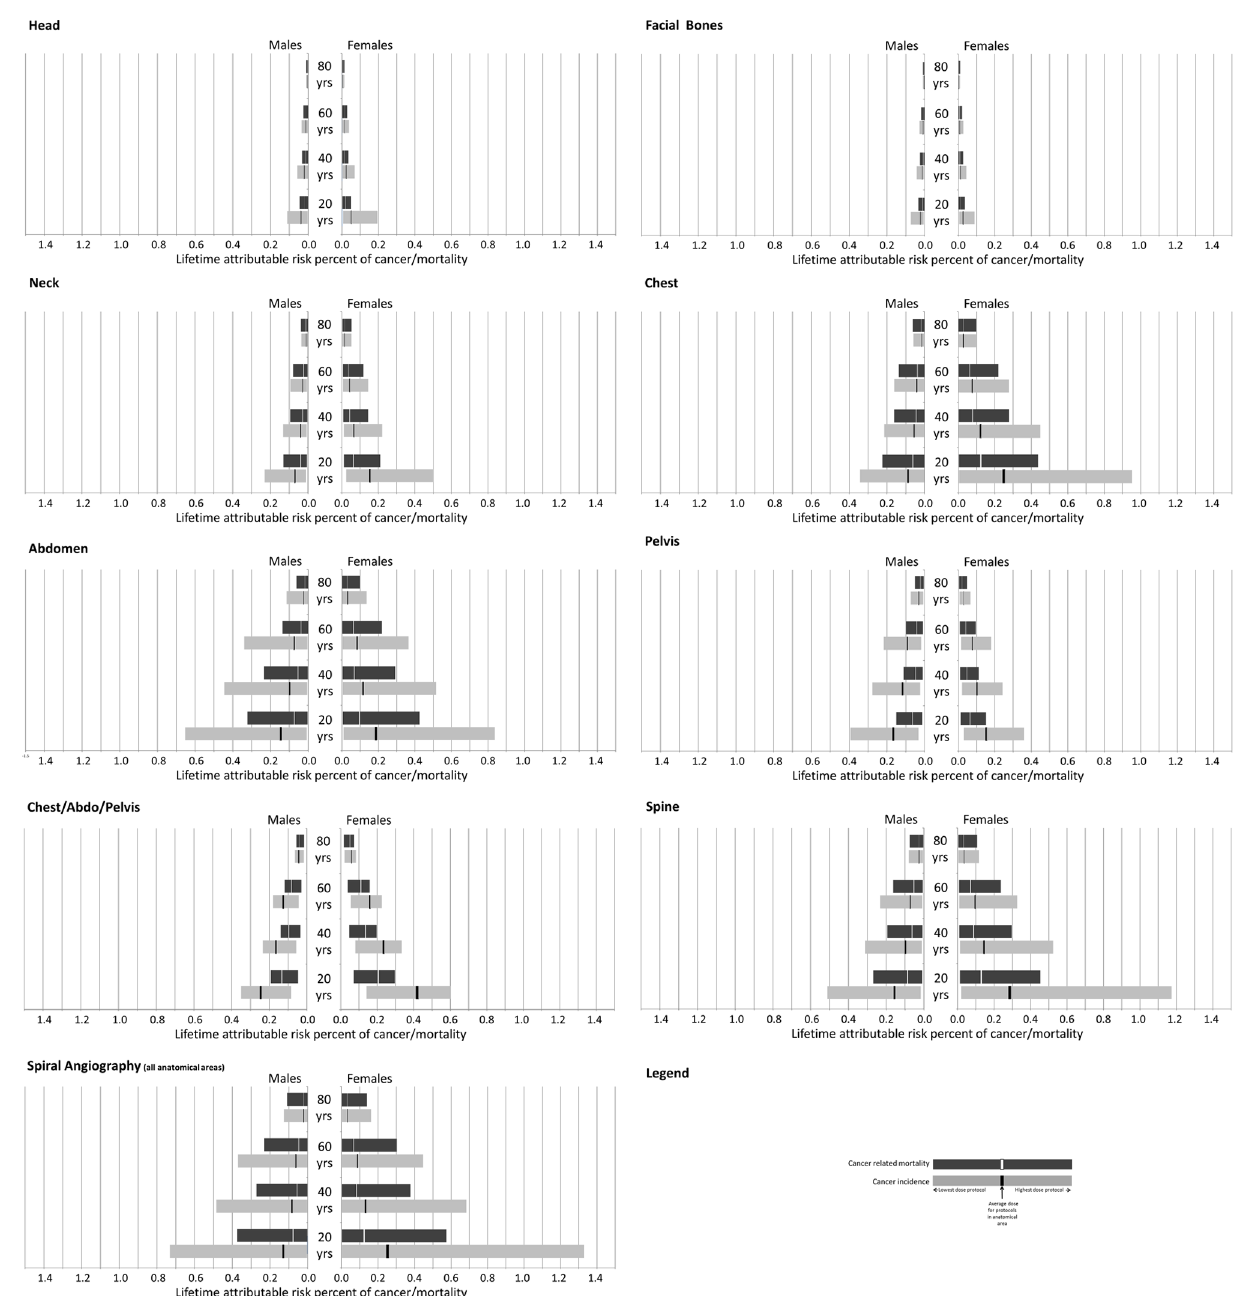
Figure 2. Variation in the lifetime attributable risk percent of cancer incidence (light bars) and mortality (dark bars) according to gender and age at a single exposure from CT scanning protocols grouped according to anatomical